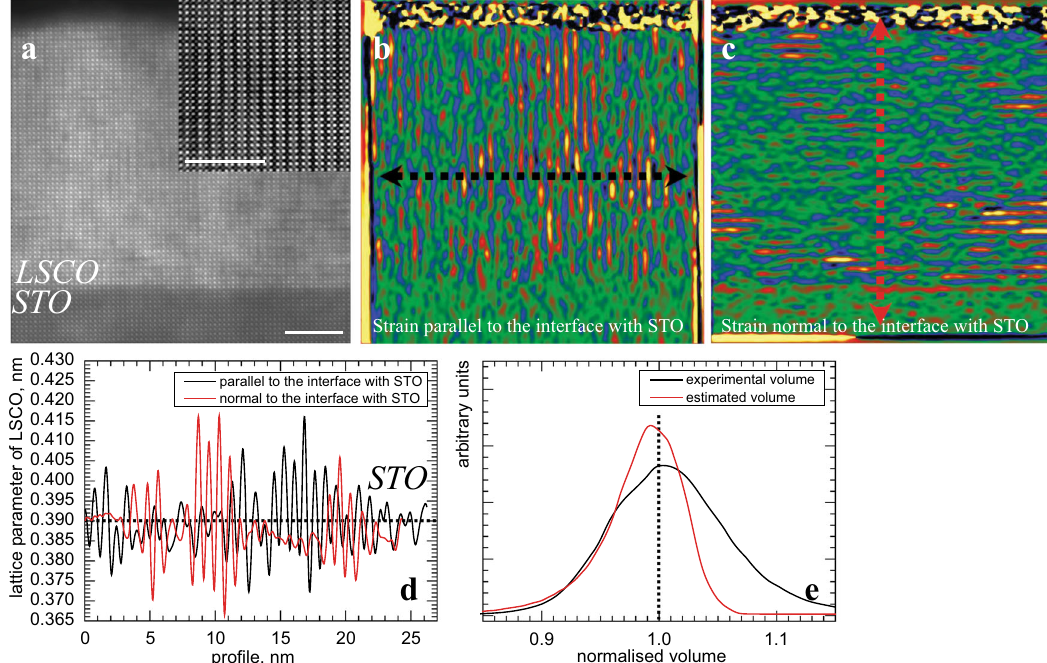
Fig. 8 Geometrical Phase Analysis of LSCO thin fi lm grown on STO(100) substrate. a HAADF STEM image, b , c strain mapping parallel and normal to the interface with the substrate, d pro fi les of the in-plane and out-of-plane lattice parameter corresponding to the dashed lines in b and c , e cell volume of the LSCO normalized to its bulk value measured and estimated by assuming a simple elastic model. The insert in a shows the magni fi ed HAADF image of the region with Brownmillerite phase schematically demonstrated in Fig. 1a. The scale bar is 5